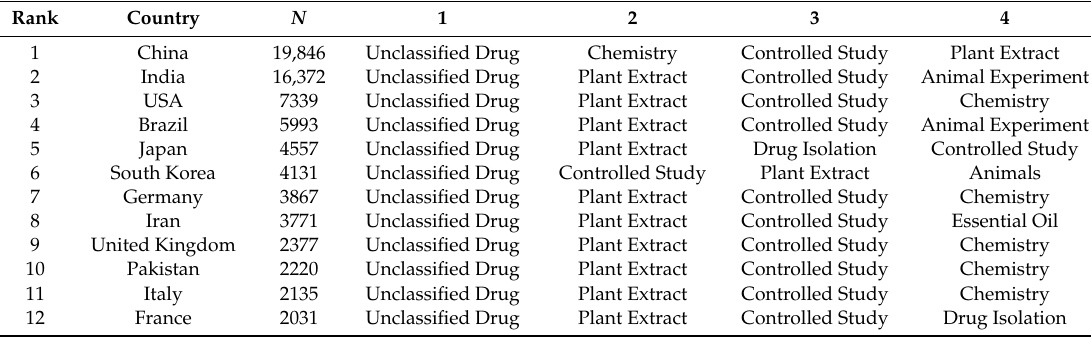
Table 3. Main keywords by country.